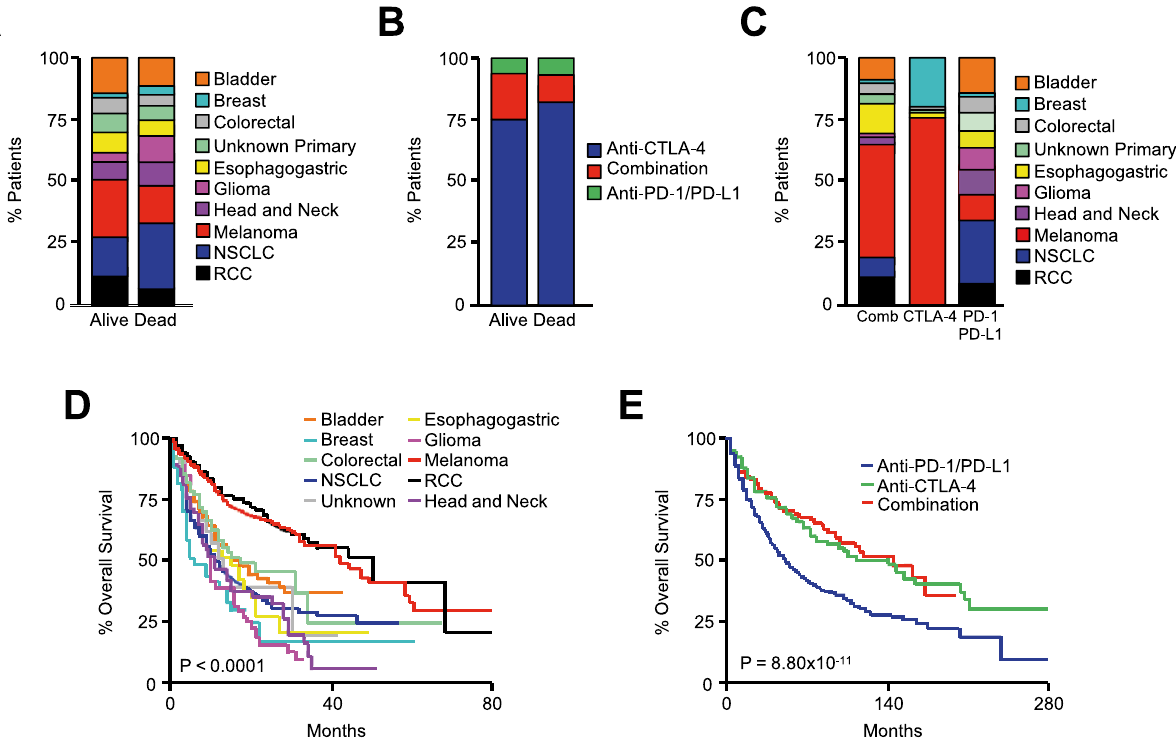
Figure 1. Clinical characteristics of patients receiving immune checkpoint inhibitors. ( A ) The Samstein et al. MSKCC pan-cancer cohort of 1661 patients receiving PD-1, PD-L1, and/or CTLA-4 inhibiting antibodies were arranged by vital status, and the tumor types represented in each group displayed by percent. ( B ) The percent of patients in each group receiving anti-PD-1/PD-L1 antibodies (N = 1307), anti-CTLA-4 antibodies (N = 99), or a combination of both (N = 255). ( C ) The percent of each tumor type arranged by treatment group. ( D , E ) Kaplan Meier plot showing overall survival for patients arranged by either cancer type or treatment